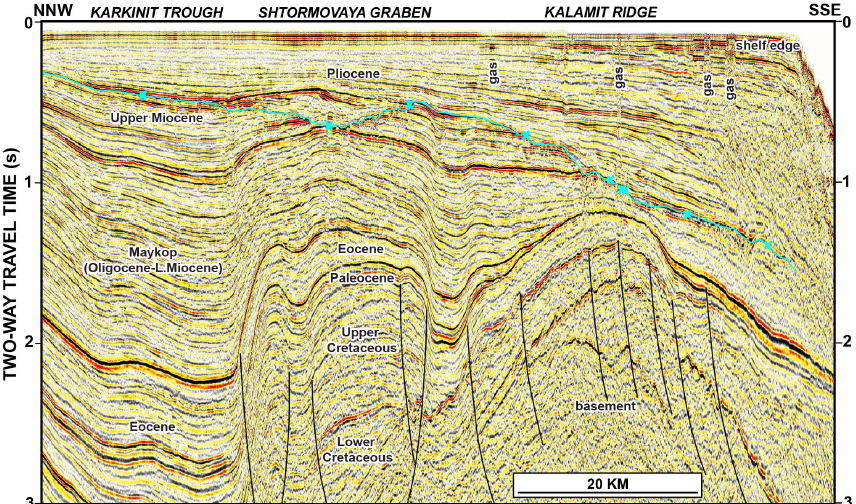
Figure 12. Seismic reflection evidence for post-Sarmatian inversion. For location, see Fig. 8. The southward prograding Pliocene sequence above the Sarmatian (late Miocene) unconformity (shown in blue) is clearly back-rotated. This is due to the multiple episodes of inversion forming the overall structure containing the relatively small Shtormovaya field on its northern flank (e.g. Khriachtchevskaia et al., 2009). Note the gradual incorporation of the earlier Eocene folds into a much larger Miocene to Pliocene inversion anticline. Vertical exaggeration is ∼ 6 × assuming an average seismic velocity of 4kms − 1